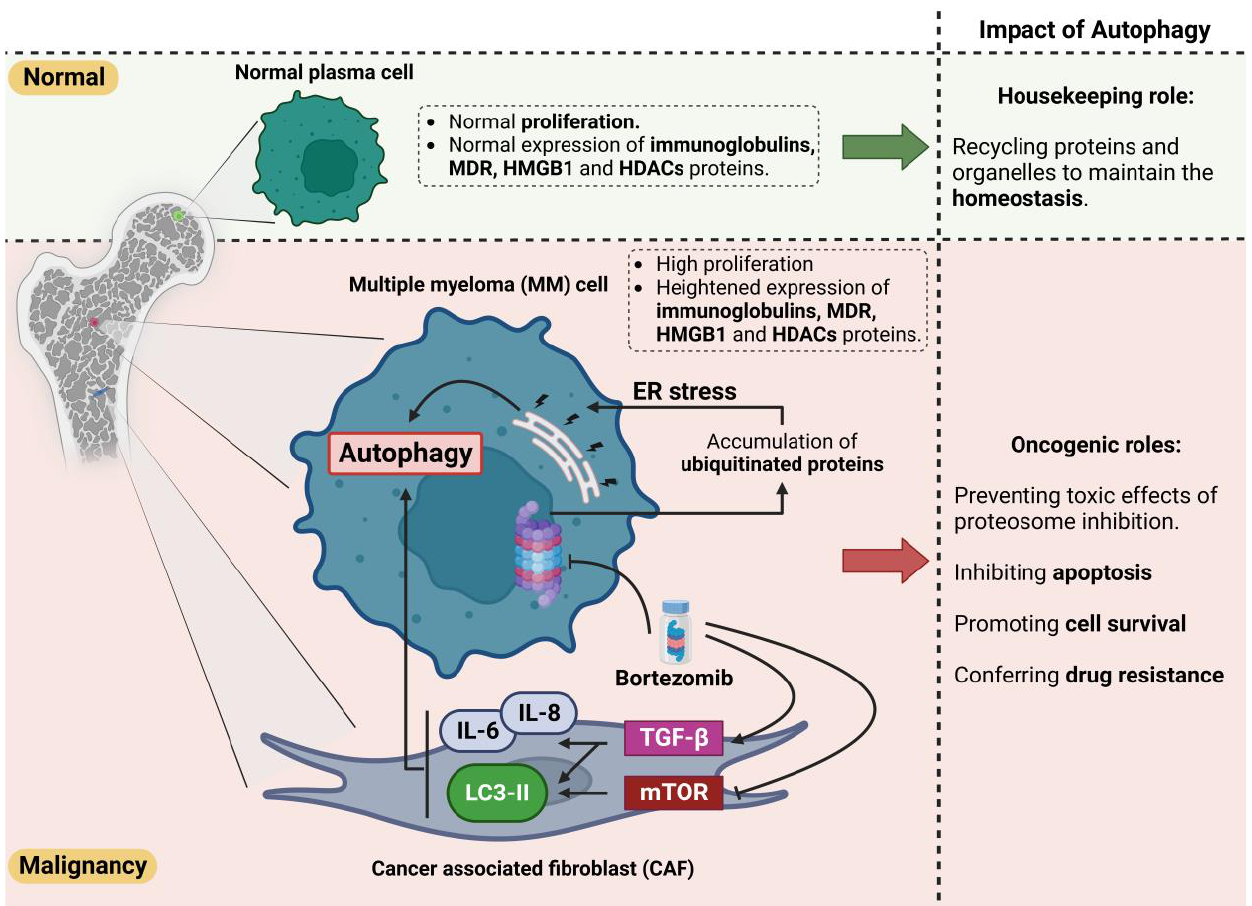
Figure 3. Dual role of autophagy in normal and malignancy conditions. Autophagy plays a protective role in the homeostasis of normal cells via recycling of the aggregated/unfolded/misfolded proteins and defective organelles. However, this protective effect could enhance the survival of tumor cells by clearing the accumulated proteins and improving their turnover, thereby inhibiting apoptosis. Moreover, autophagy could cause resistance to bortezomib by inducing ER stress in MM cells and triggering the pro-autophagic pathways in cancer-associated fibroblast cells (CAFs). Height- ened autophagy clears the bortezomib-induced accumulation of ubiquitinated proteins. The MM cells could subsequently escape from apoptotic pathways and survive during treatment.